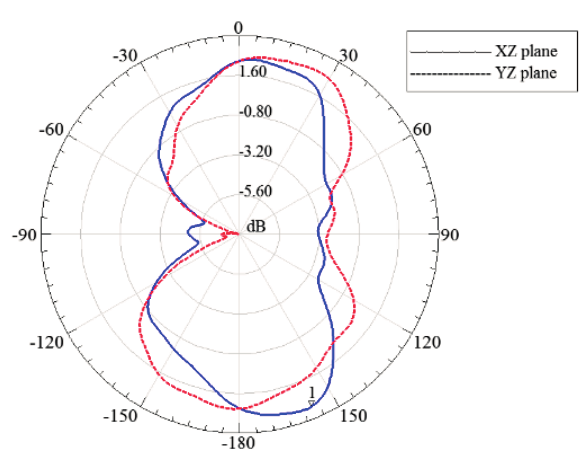
Figure 6. Radiation pattern simulation results of the